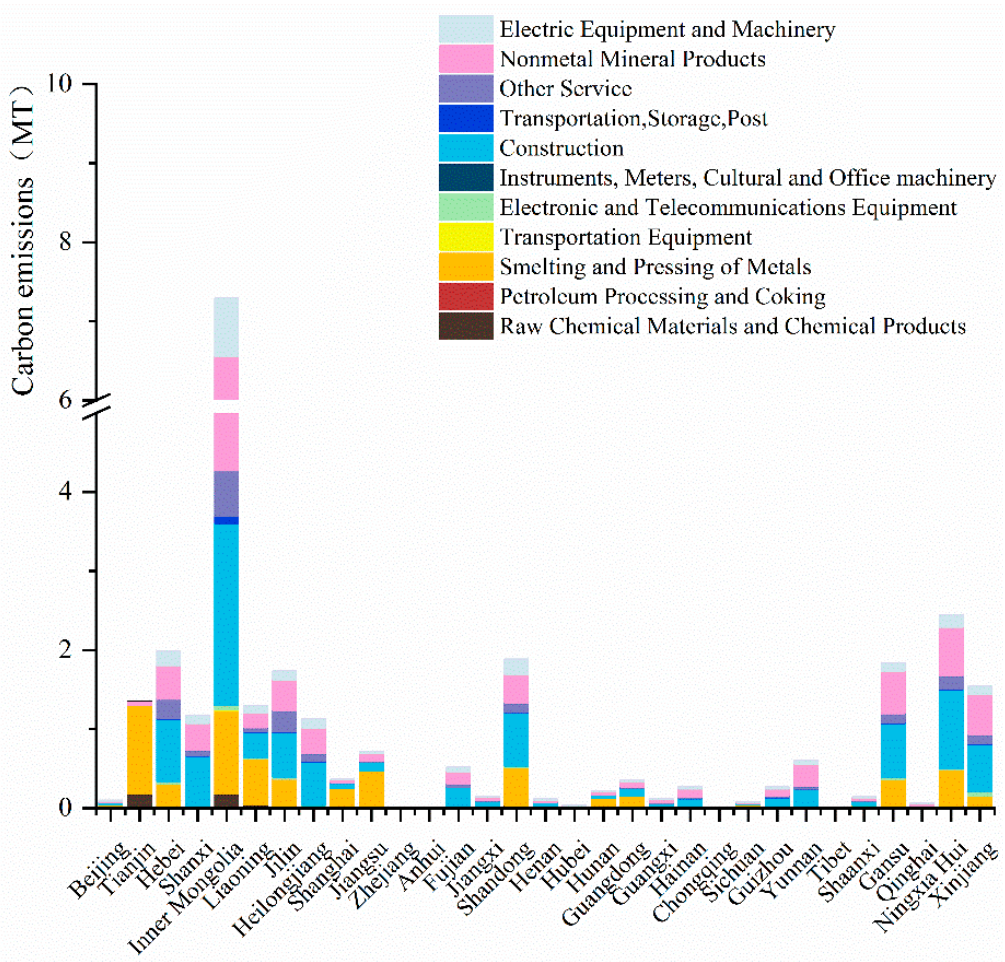
Figure 6. Proportion of carbon emissions from different sectors in each province. Figure 7 reflects the flows of embodied carbon emissions caused by the transfer of turbines among provinces. Different colors on the circle represent different